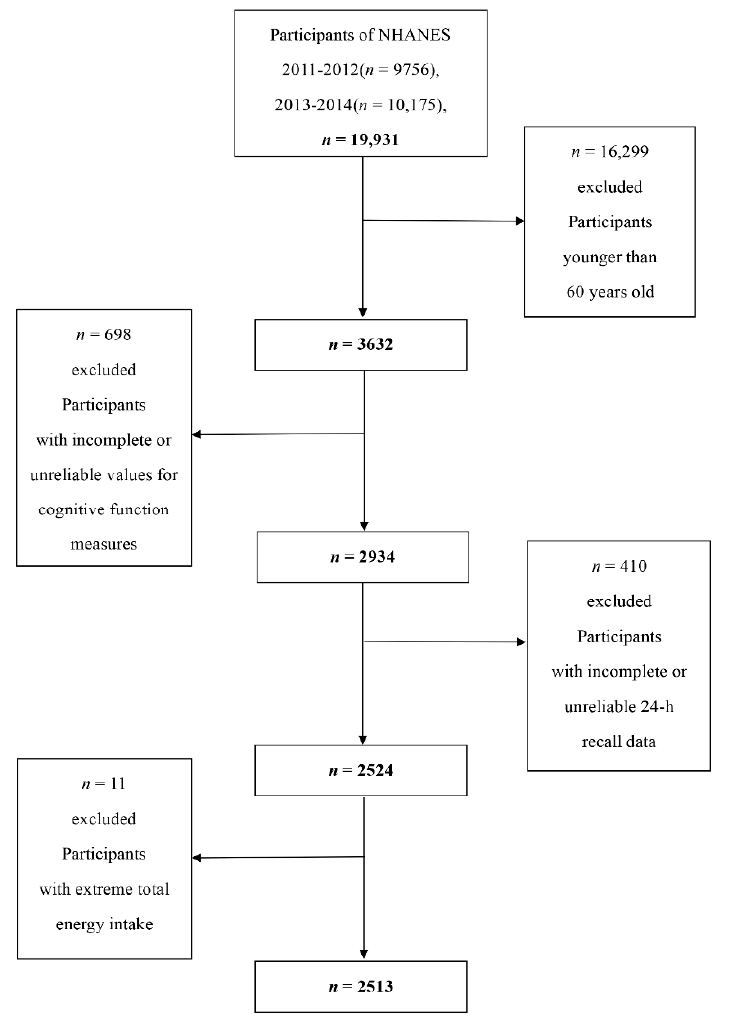
Figure 1. Flow chart of the screening process for the selection of eligible participants.